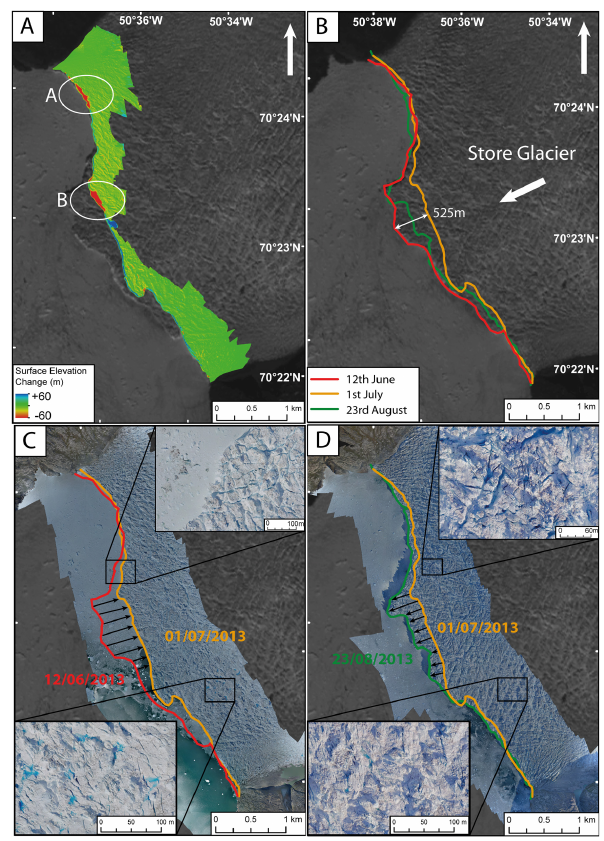
Figure 3. (a) Surface elevation difference between two DEMs col- lected on 1 July and 2 July. Red areas show elevation loss whilst blue areas show elevation gain. White circles highlight the calving events that occurred between the two UAV surveys. (b) The position of the calving front of Store Glacier during the summer of 2013. (c) Calving-front retreat observed between 12 June and 1 July. Inset is an orthorectified image of the water-filled crevasses observed on 1 July with a pixel resolution of 30cm. (d) Calving-front advance observed between 1 July and 23 August. Inset is an orthorectified image showing water-filled crevasses observed on 23 August. The coverage and size of water-filled crevasses is